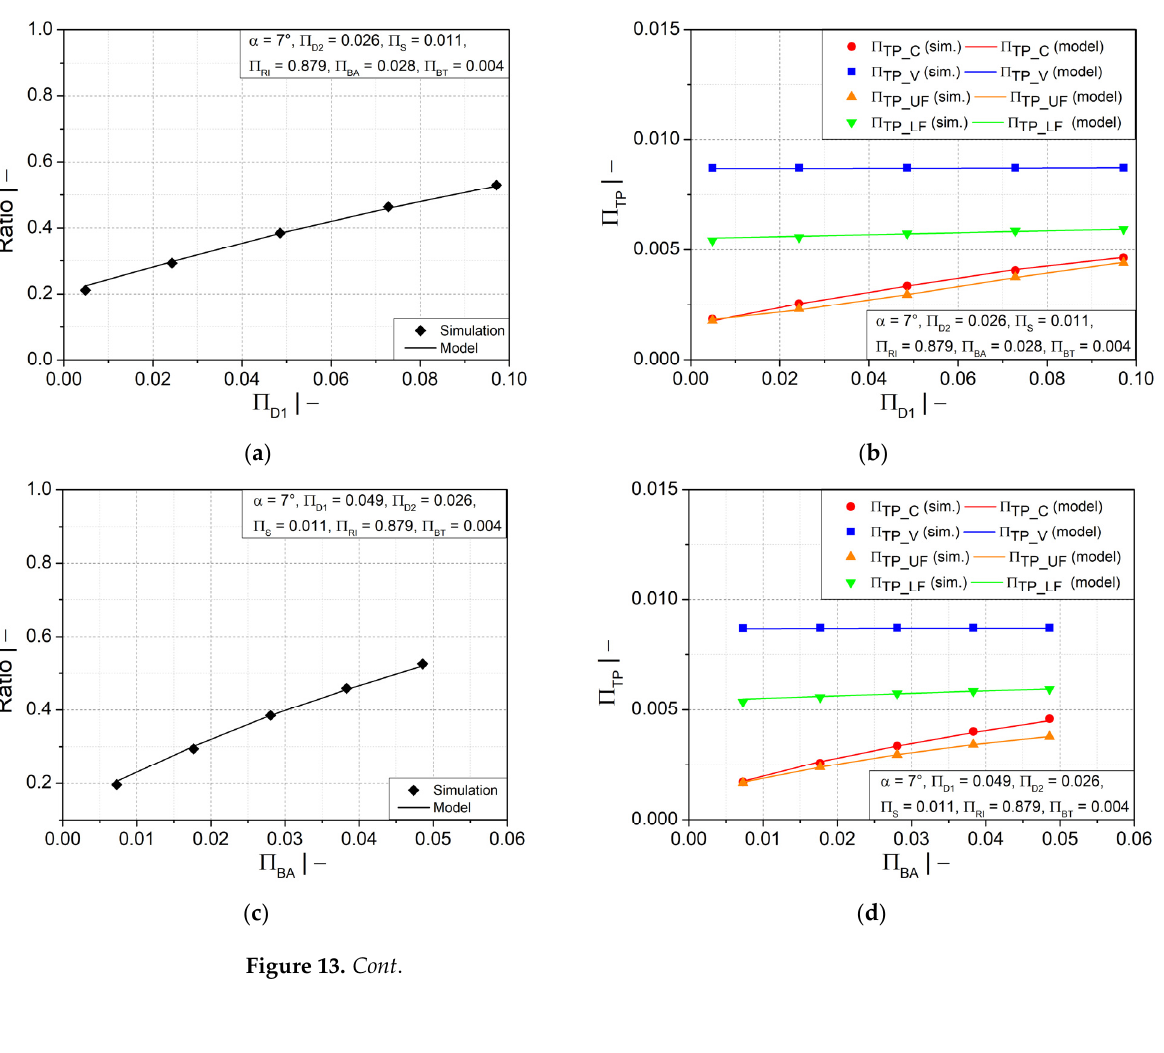
Figure 13. Comparisons of the estimated models for wall thickness distribution ratio and dimen ‐ sionless wall thickness at several evaluation positions as functions of ( a , b ) dimensionless crest di ‐ ameter ∏ (cid:3005) (cid:3117) , ( c , d ) dimensionless half profile width at crest ∏ (cid:3003) (cid:3250) , ( e , f ) dimensionless mold block in ‐ ner radius ∏ (cid:3019) (cid:3258) . ( a )